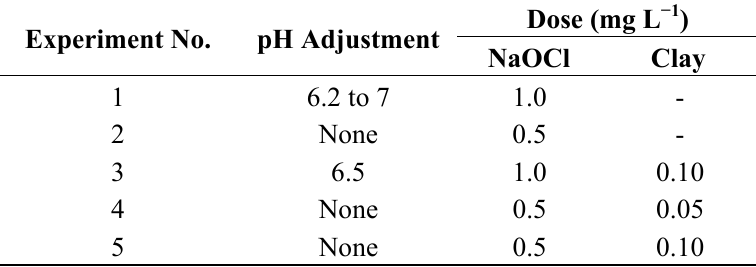
Table 2. Configuration of Jar Test experiments.